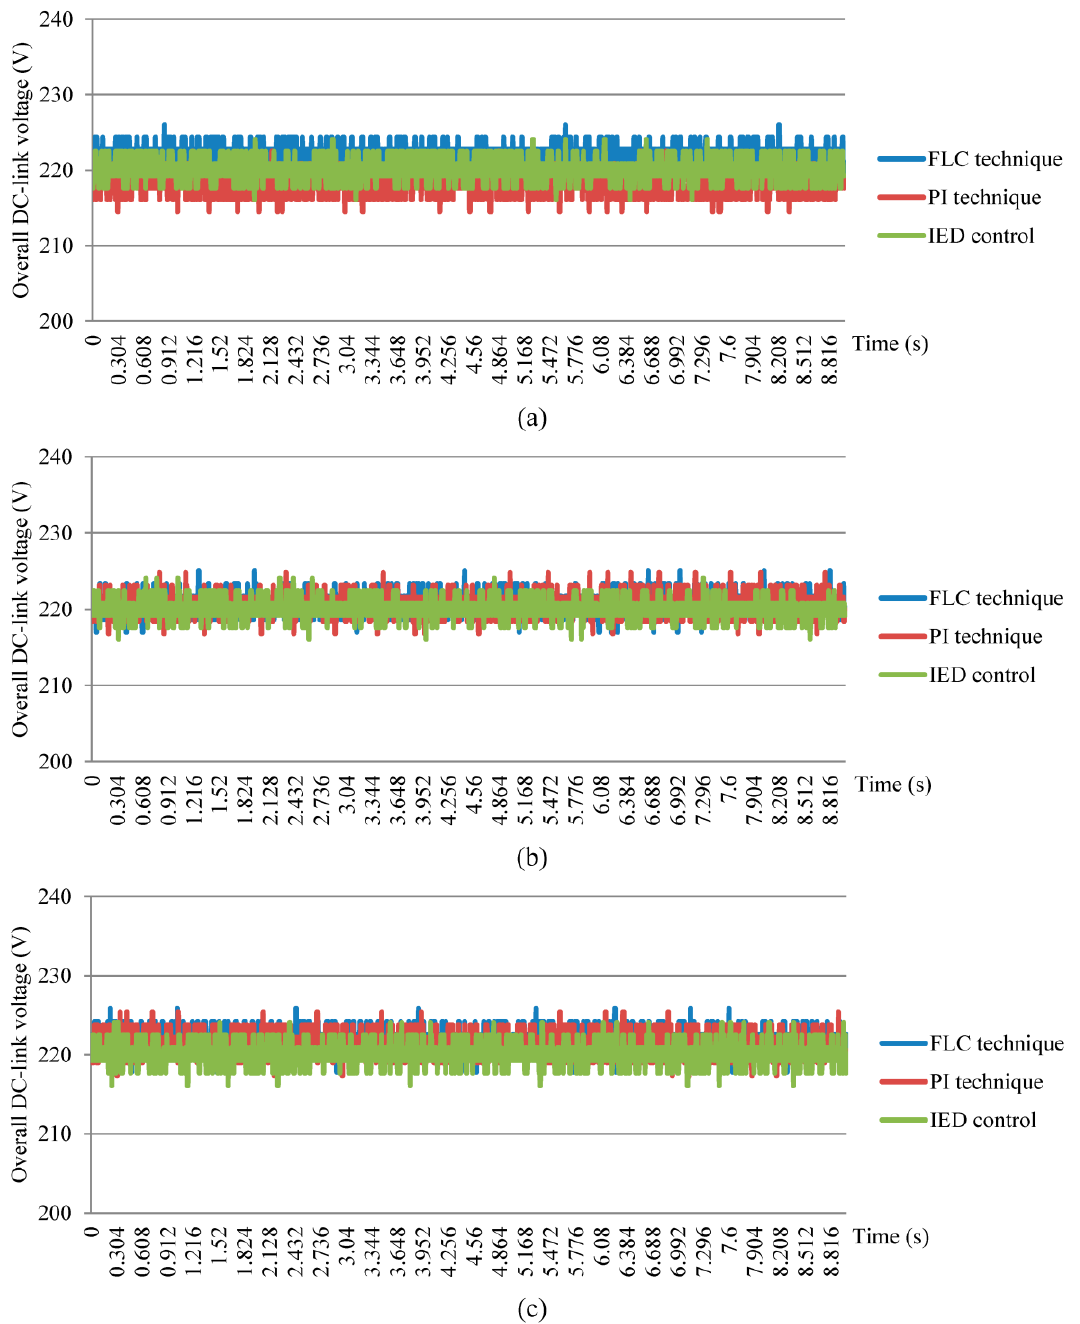
Figure 14. Performance comparison of DC-link capacitor voltage regulation algorithms with reference voltage of 220 V for steady-state conditions of ( a ) capacitive; ( b ) inductive and ( c ) resistive loads.